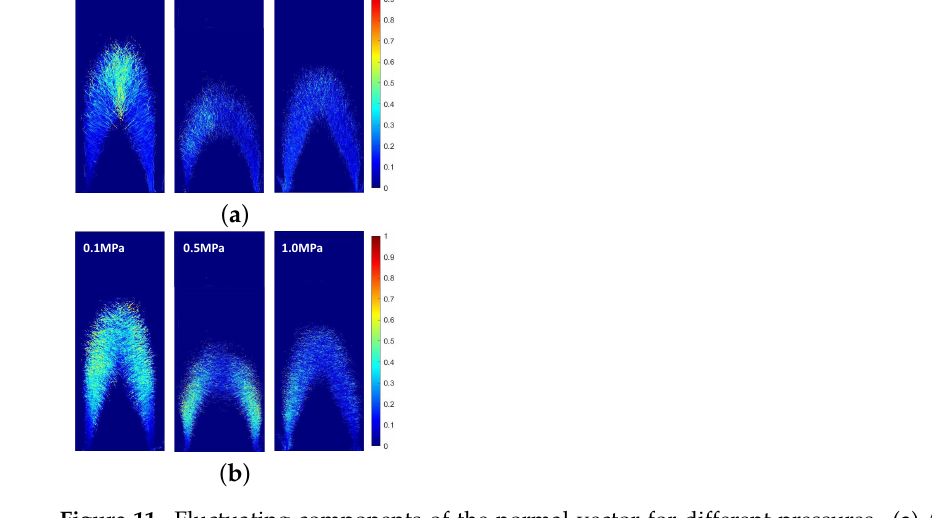
Figure 11. Fluctuating components of the normal vector for different pressures. ( a ) (cid:104) m 2 D x m 2 D x (cid:105) s ; ( b ) (cid:104) m 2 D y m 2 D y (cid:105) s